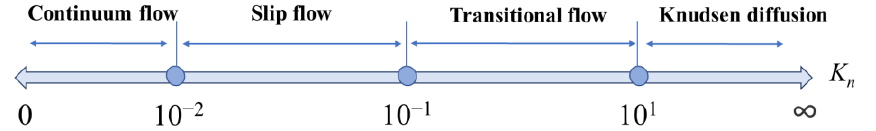
Figure 3. Classification of gas molecular flow types (modified from [48]).